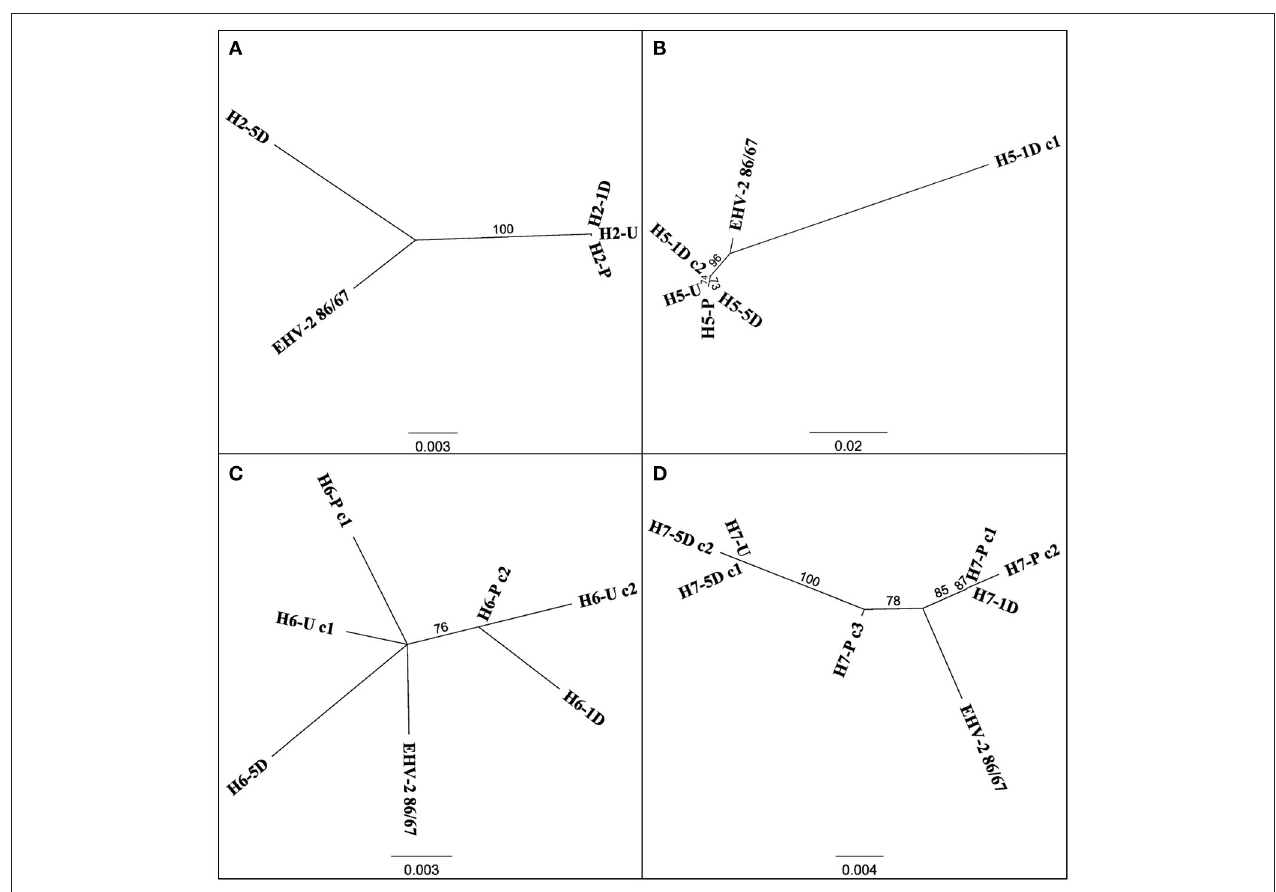
FIGURE 2 | Unrooted phylogenetic trees comparing EHV-2 reference strain 86/87 and multiple strain types within individual horses 2 (A) , 5 (B) , 6 (C) , 7 (D) . Sequences are labeled according to Horse (H-), time point of sample taken (Pre Transport [-P], Unloading [-U], 1 day post transport [-1D], 5 days post transport [-5D]) and clone (c-) number if more than one sequence was isolated from each sample. Scale bars represent substitutions per